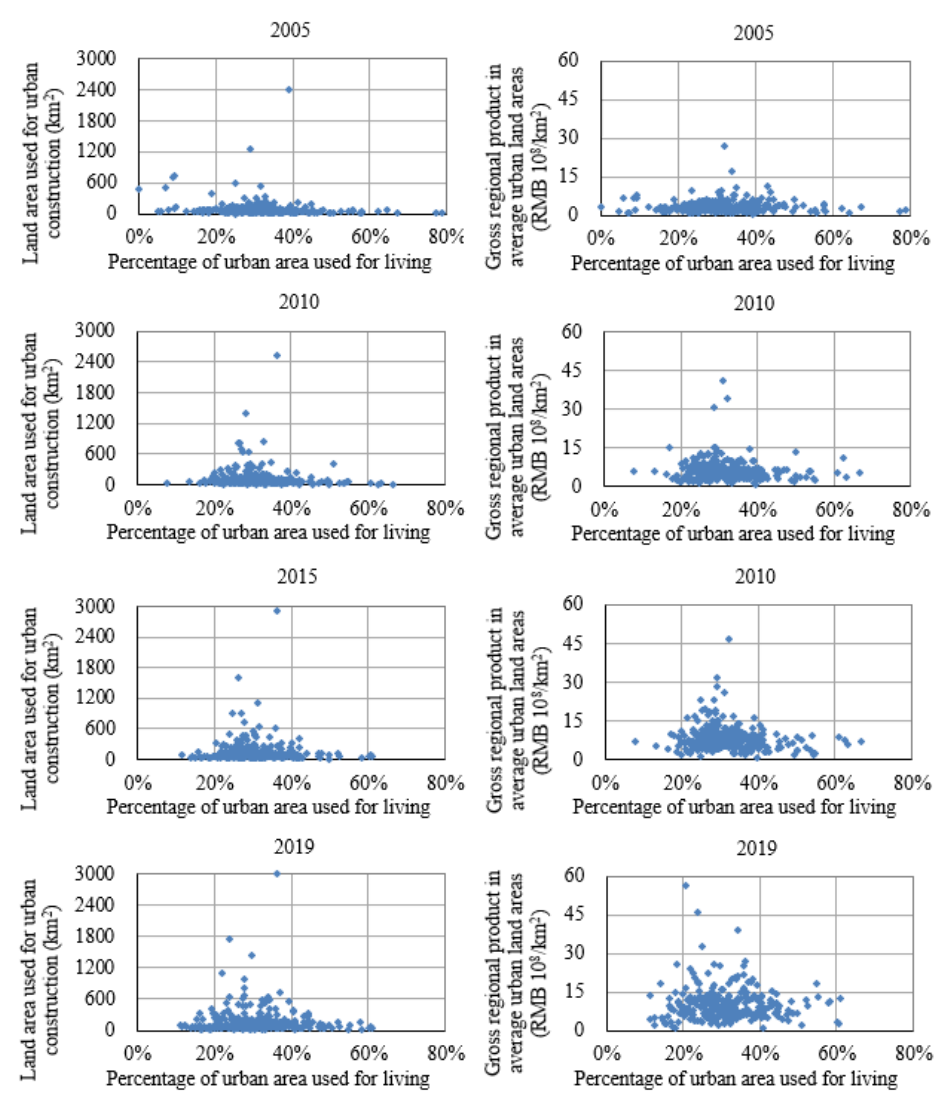
Figure 7. The scatter diagrams of land area used for urban construction, gross regional product in average urban land areas, and percentage of urban area used for living.